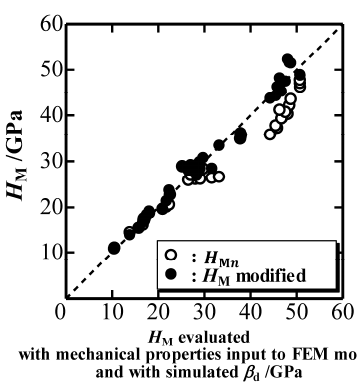
Figure 8. Indentation hardness H M estimated with simulated P - h curves plotted against H M evaluated with mechanical properties inputted into the FEM model and with simulated β d .